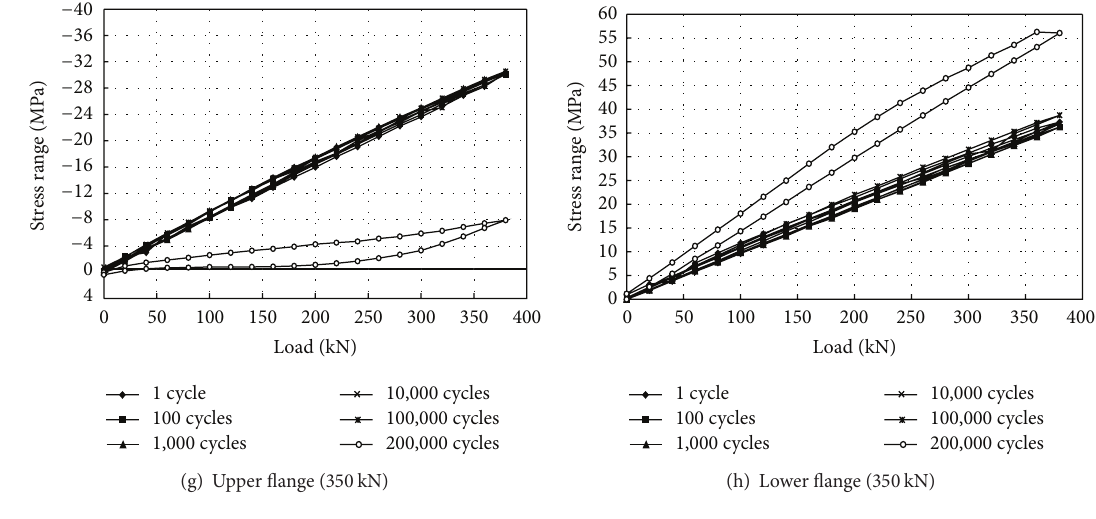
Figure 7: Load Range-Stress Correlation at Span Length of 2.0 m.